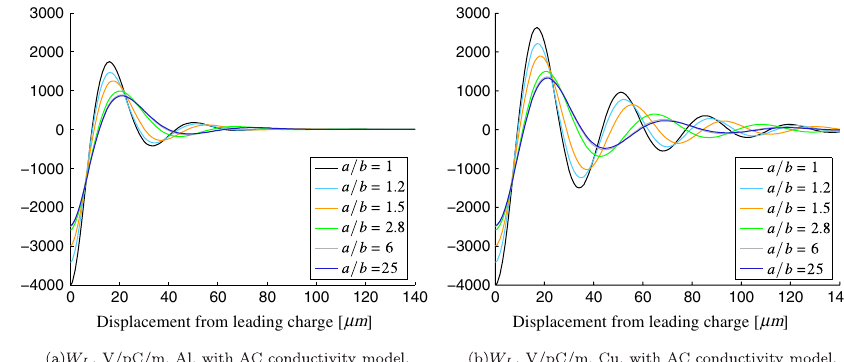
FIG. 5. (Color) Dependence of longitudinal wake functions on the longitudinal displacement behind the leading charge. Semiminor axis b (cid:4) 3 mm , AC conductivity models for aluminum (a) and copper (b), and several aspect ratio values a=b